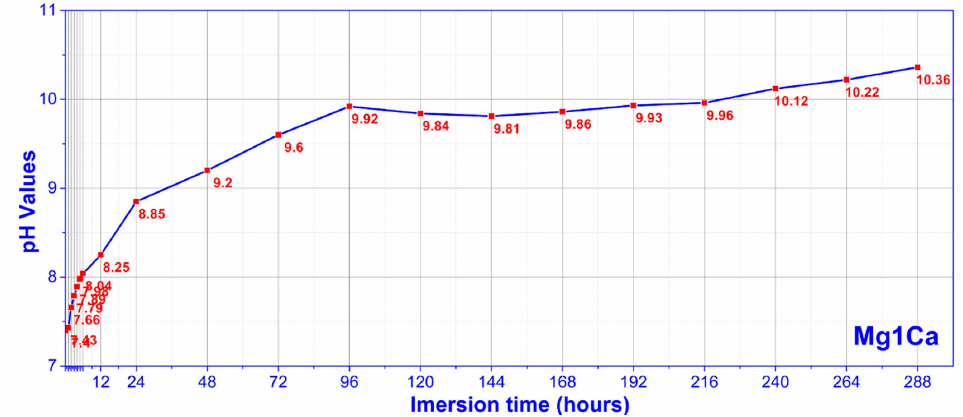
Figure 6. pH evolution in SBF (mean values for three samples).